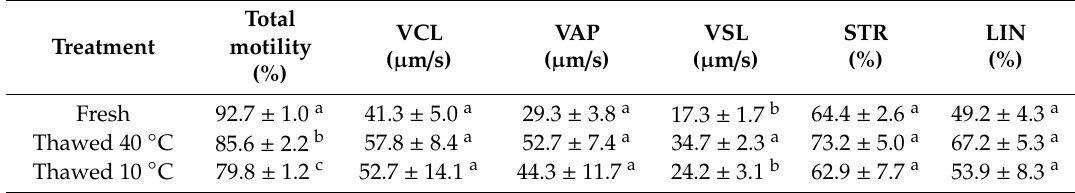
Table 1. Computer-Assisted Sperm Analysis (CASA) parameters recorded for fresh semen or frozen semen (mean ± SE) undergoing two di ff erent thawing rates ( n = 5).